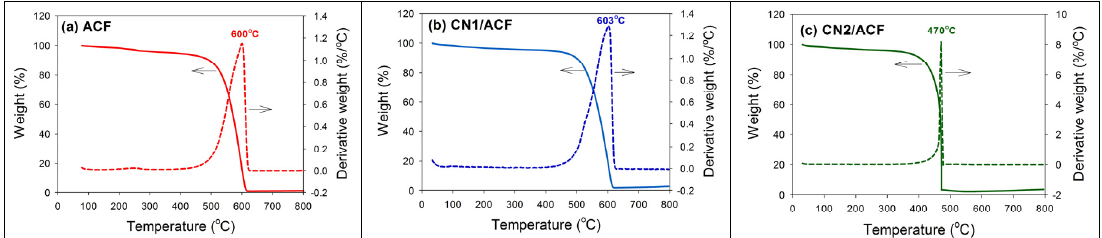
Figure 2. Thermogravimetric analysis (TGA) and differential thermogravimetry (DTG) profiles of the samples: ( a ) as-received activated carbon fibers (ACF); ( b ) ACF grafted with N-doped carbon nanotubes (CN1/ACF); ( c ) ACF pre-immersed with cobalt(II) acetate and grafted with N-doped carbon nanotubes (CN2/ACF).